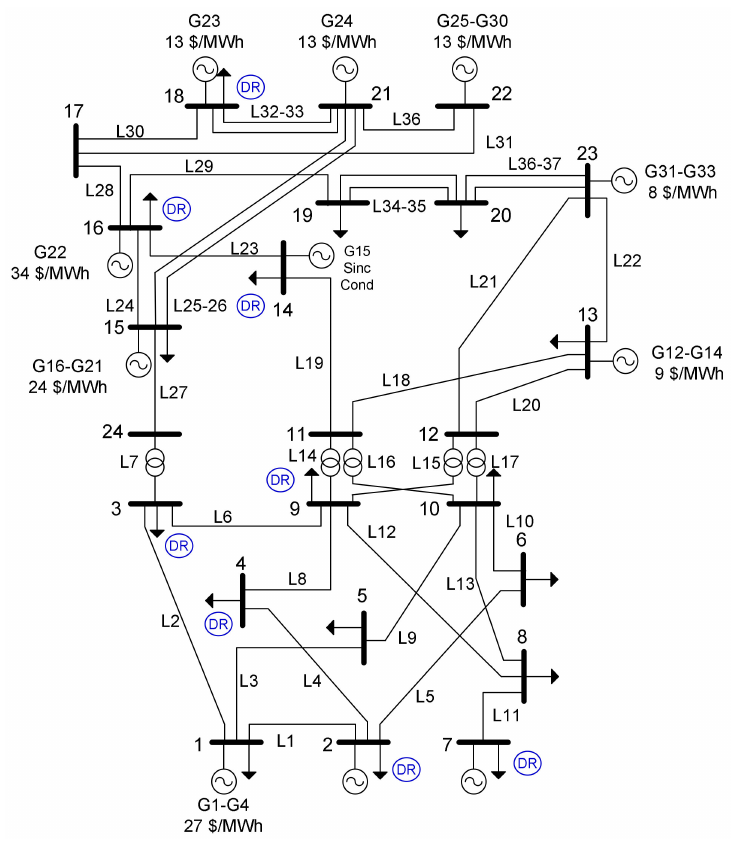
Figure 8. Modified version of the IEEE RTS-24 bus test system.